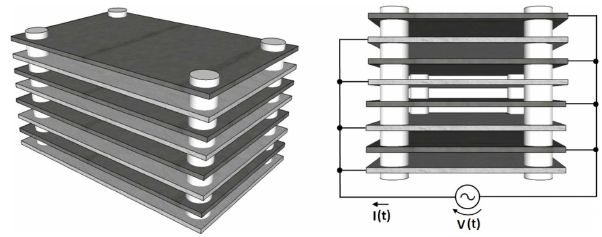
Figure 6. Parallel plate capacitive sensor used to investigate the properties of vegetable